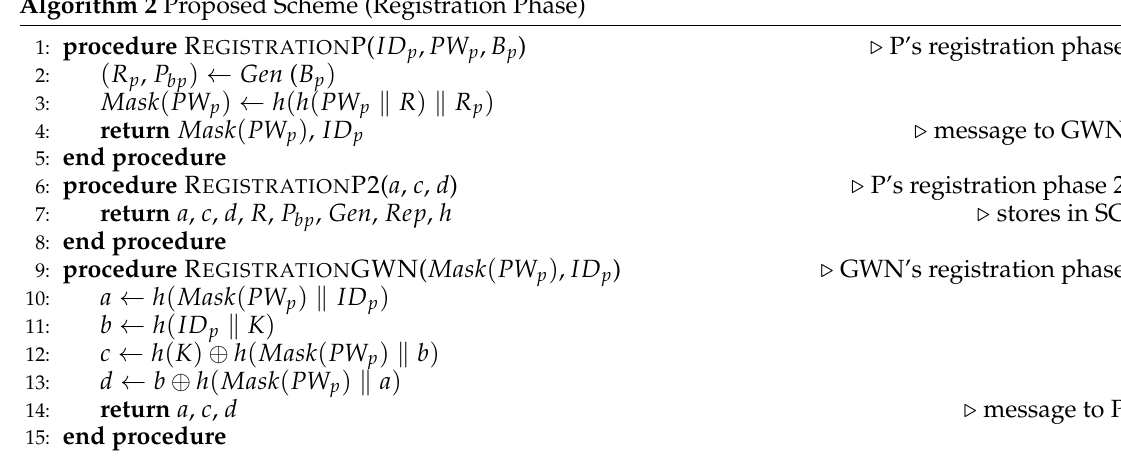
Algorithm 2 Proposed Scheme (Registration